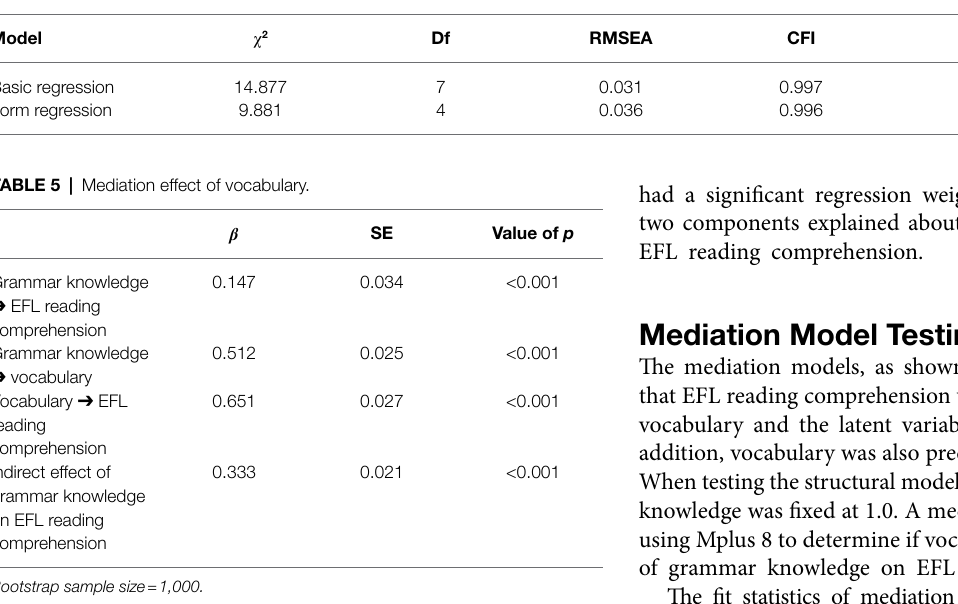
TABLE 4 | Model fit indices for the basic regression and form regression models.